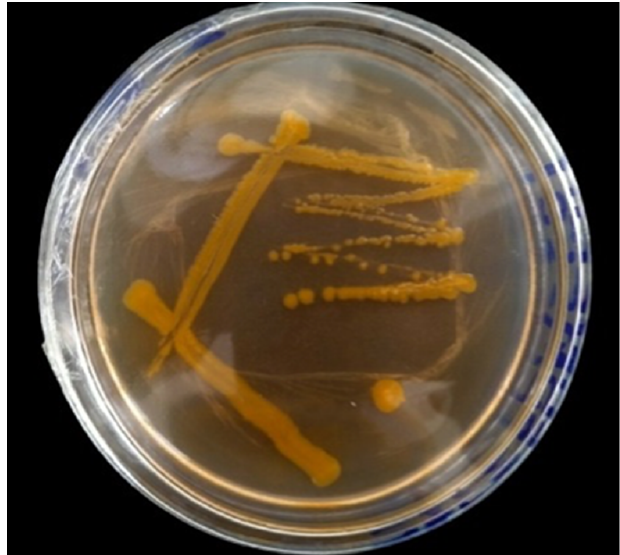
Figure 1. Isolation of canker infected samples from a citrus plant and after purification, Xanthomonas citri pv. citri appeared as yellow colonies on a nutrient agar plate.